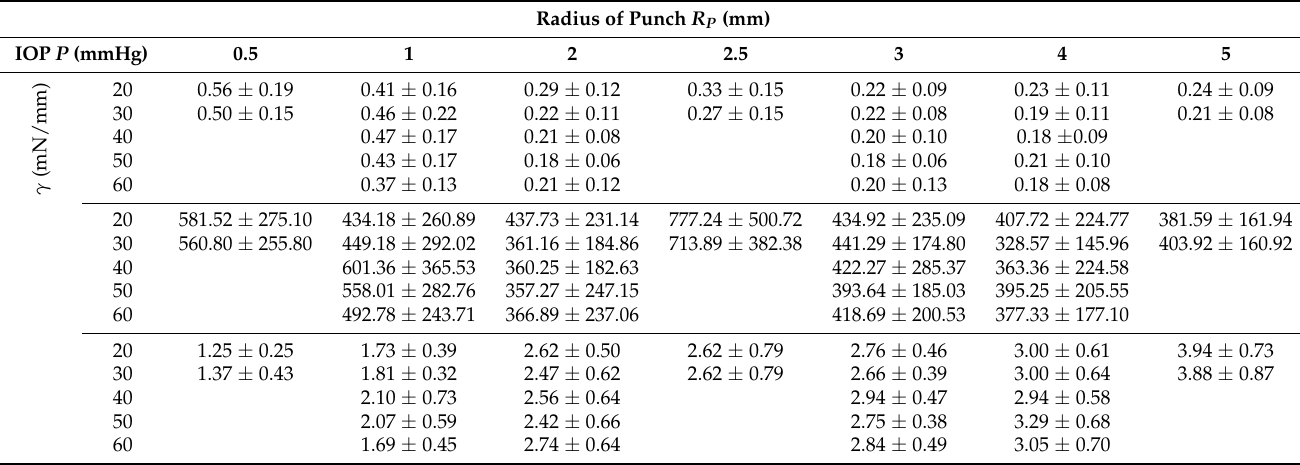
Figure 3. Scale effect of corneal adhesion: ( a ) work of adhesion γ ; ( b ) effective elastic modulus E * ; ( c ) adhesion force, F ad , under normal IOPs of 20 and 30 mmHg, respectively (* p < 0.05, ** p < 0.01, and *** p < 0.001; n.s indicates no statistical differences among the groups, with p > 0.05). Table 1. The data of γ , E* , and F ad obtained from the test performed